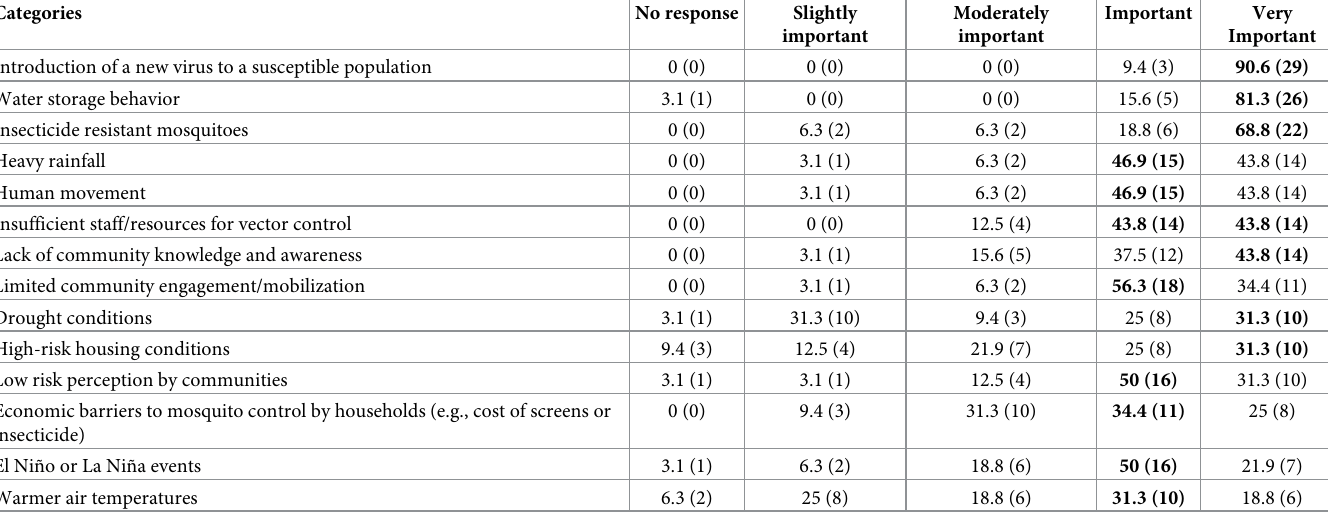
Table 4. The relative importance of factors that trigger epidemics of diseases transmitted by Aedes aegypti , as reported by survey respondents. Results shown as % (n) of survey respondents, ranked by risk factors identified as “very important.” The most frequent responses are marked in